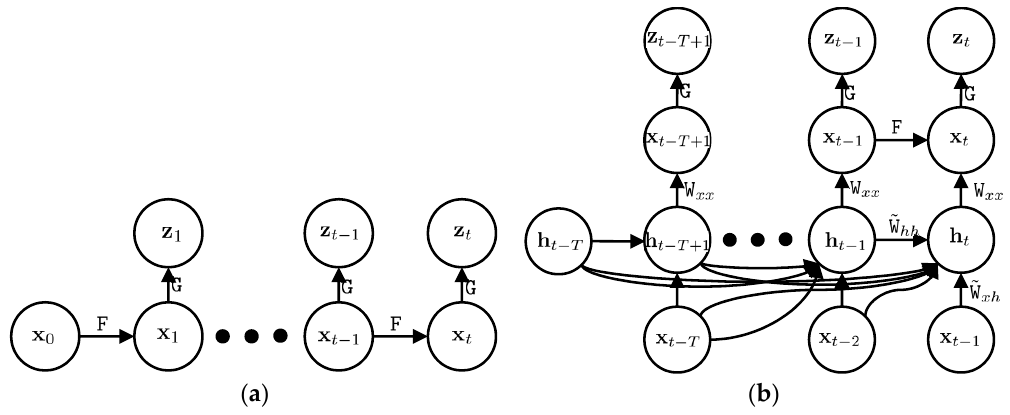
Figure 2. The probabilistic graphical model of the Kalman filter ( a ) and deep Kalman filter ( b ); x , z , and h are the state vector, observation vector, and latent vector, respectively. The matrices F and G are the system model and observation model of the Kalman filter and W is the coefficient matrix of our proposed IMU model. The two upper layers of the deep Kalman filter are similar to the Kalman filter and the added two lower layers enable the deep Kalman filter to estimate our system model.